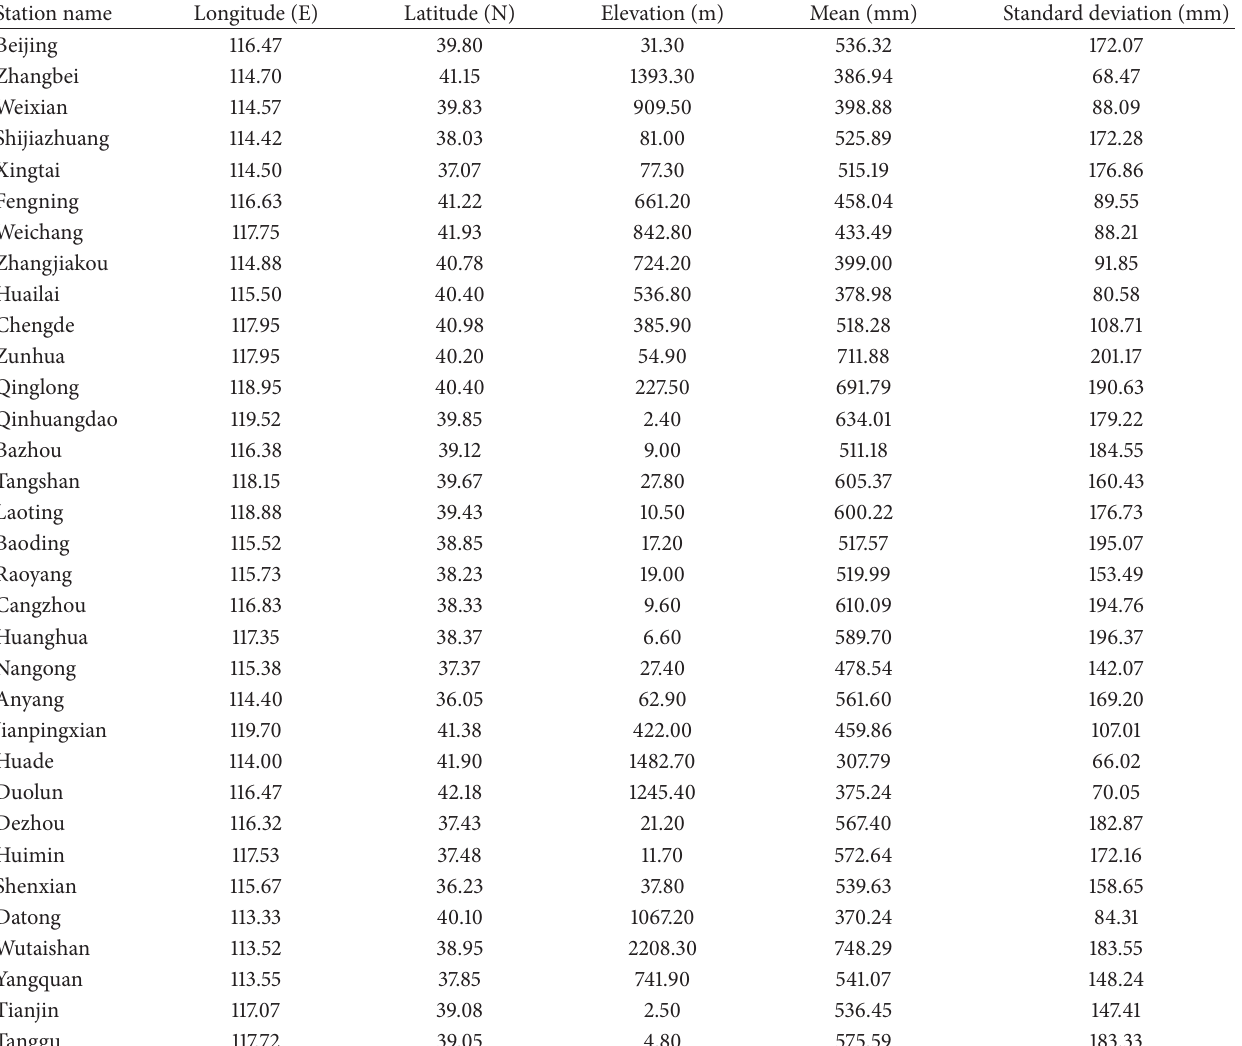
Table 1: Geographical descriptions mean and standard deviation of annual precipitation time series of the synoptic stations used in the